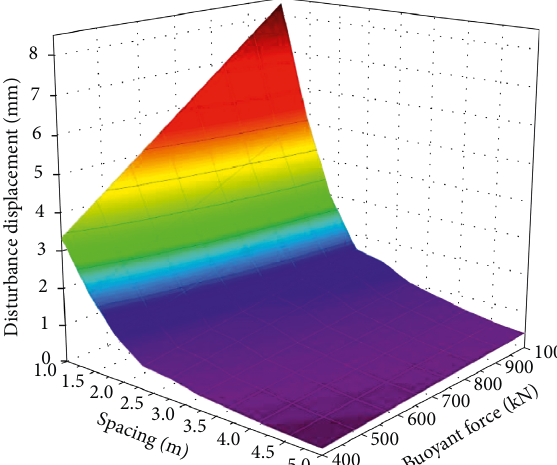
Figure 17: Variation of displacement under the action of dis- tributed